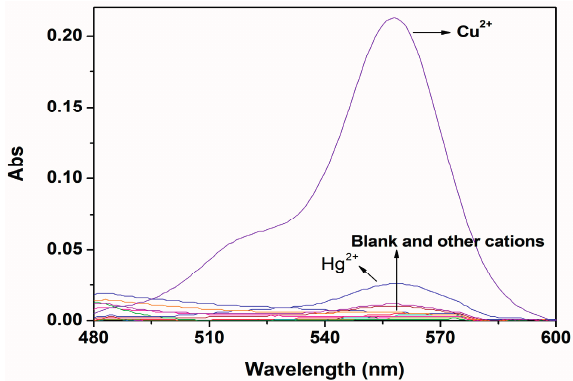
Figure 2. UV-Vis spectra of P (10 μ M) in ethanol-water solution (9:1, v:v, 20 mM HEPES, pH 7.0) upon addition of different metal ions (100 μ M).